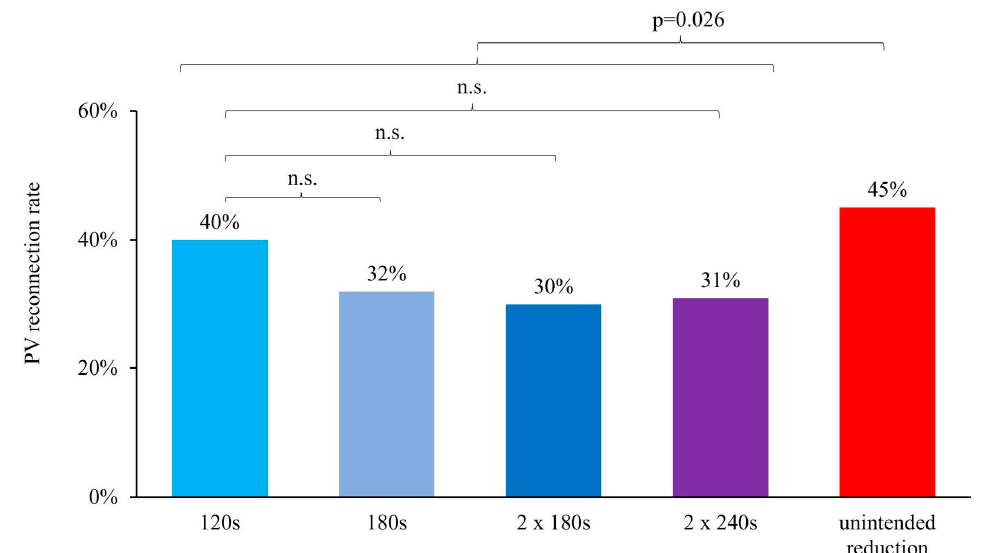
Figure 3. PV reconnection rate that depends on freeze duration during initial cryo-PVI shows no significant difference in PVs treated with intended freeze duration but significantly higher PV reconnection rates in unintended reduction in freeze duration (loss of phrenic nerve activity, e.g.). Interestingly, the highest PV reconnection rate (45%) was found for PVs, in which applied freeze duration was shorter than intended freeze duration (mostly caused